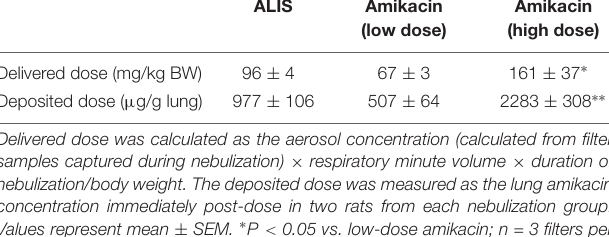
ALIS Amikacin Amikacin (low dose) (high dose)